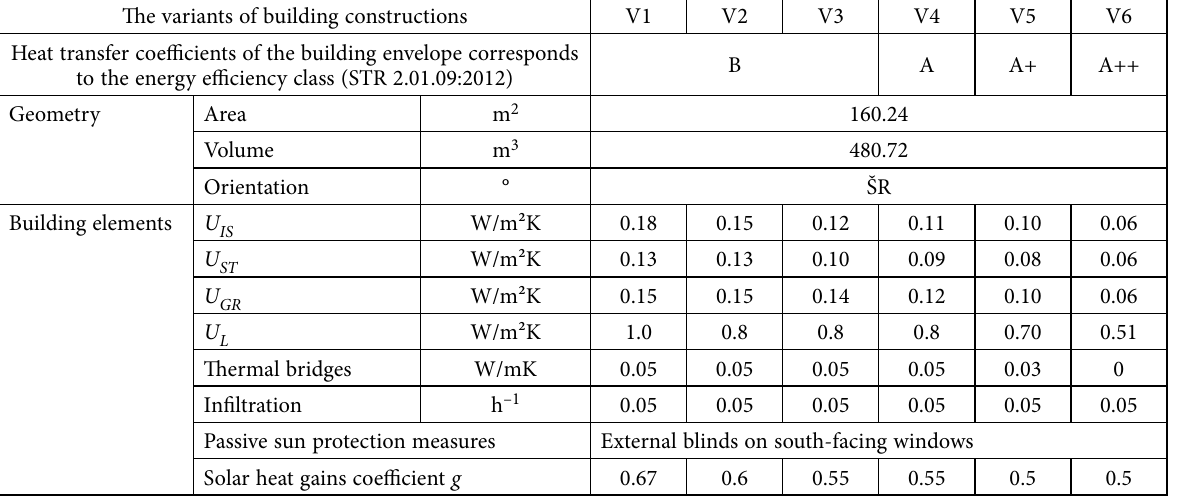
Table 3. The main characteristics of building envelope elements The variants of building